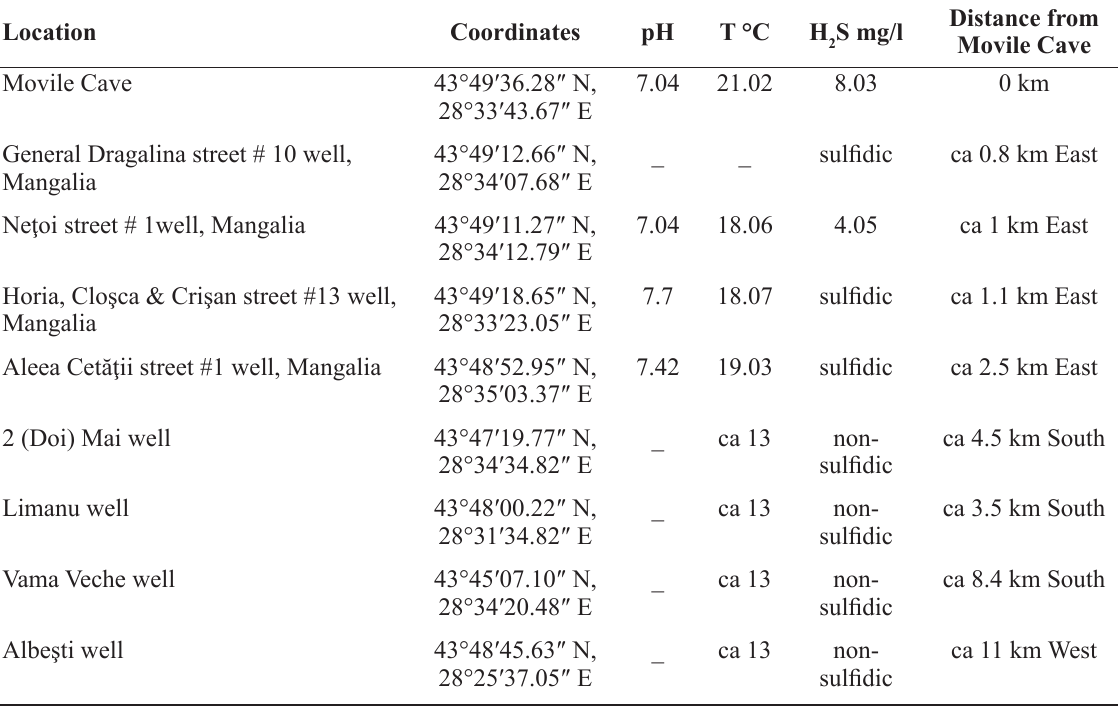
Table 1. List of sampling localities of Dendrocoelum obstinatum Stocchino & Sluys, sp. nov . , with their geographic coordinates and physico-chemical data. Not available data are indicated